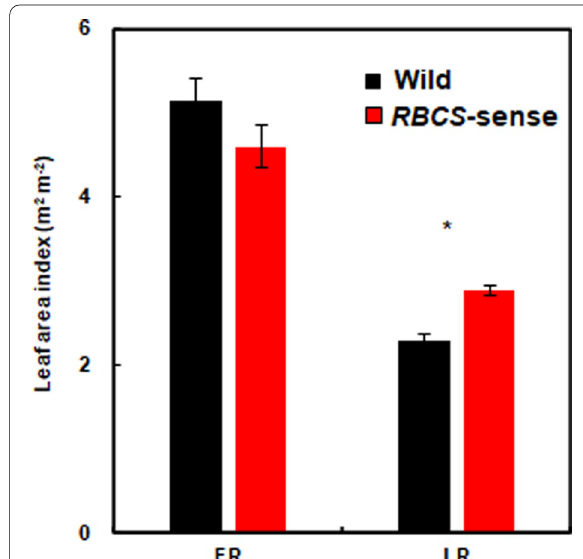
Fig. 6 Changes in the leaf area index between 10 DAH in the early ripening stages and 49 DAH in the late ripening stages in the plots with 15 g N m − 2 fertilizer. Mean values the standard error of three ± independent plots are indicated. * p < 0.05 between the wild‑type and RBCS ‑sense rice plants using Student’s t- test. The wild‑type and RBCS ‑sense rice plants are indicated by black and red bars, respectively. The abbreviations stand as follows: “ER”; early ripening stage, “LR”; late ripening stage, “ RBCS ‑sense”; transgenic rice plants overproducing Rubisco, “Wild”; wild‑type rice